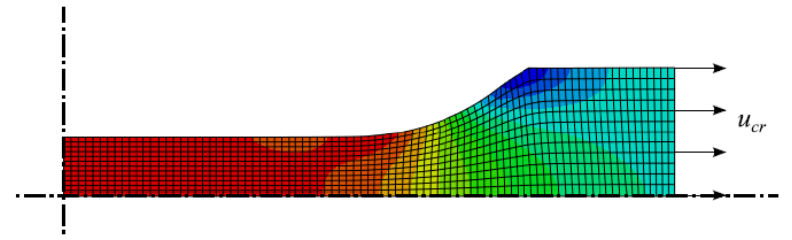
Fig. 11 Mesh and boundary conditions for uniaxial tensile test model of PVB specimen; contours of longitudinal stress at 10 mm